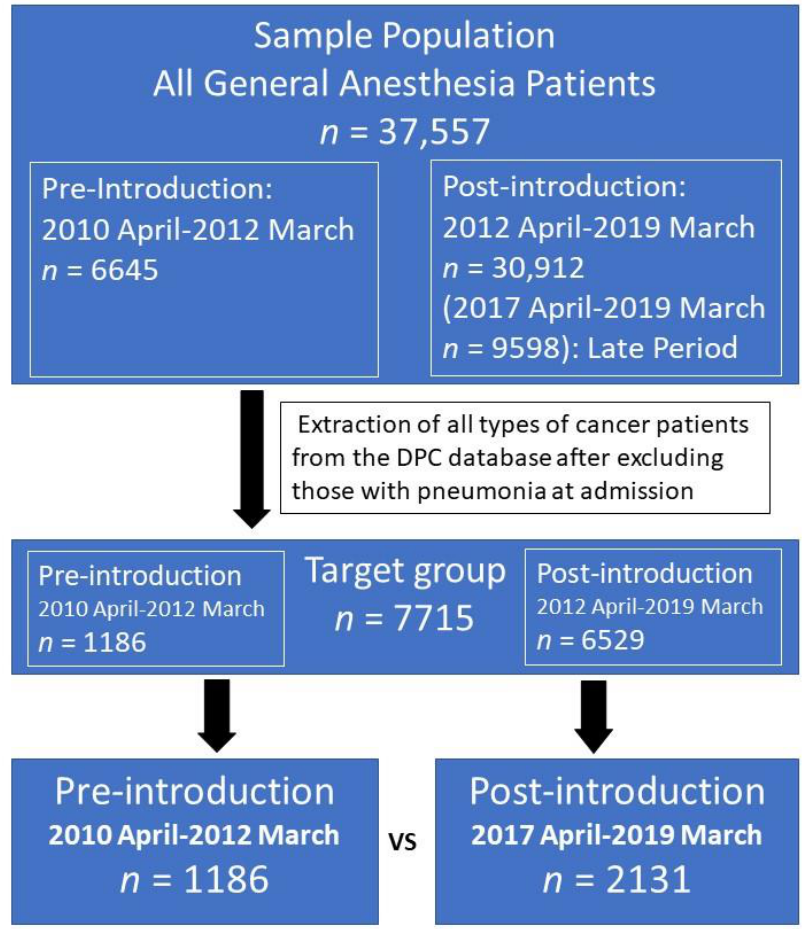
Figure 3. Schematic representation of patient selection. The final comparison is between the target patient groups two years prior to the introduction of the “oral triage” system and the last two years after its introduction.